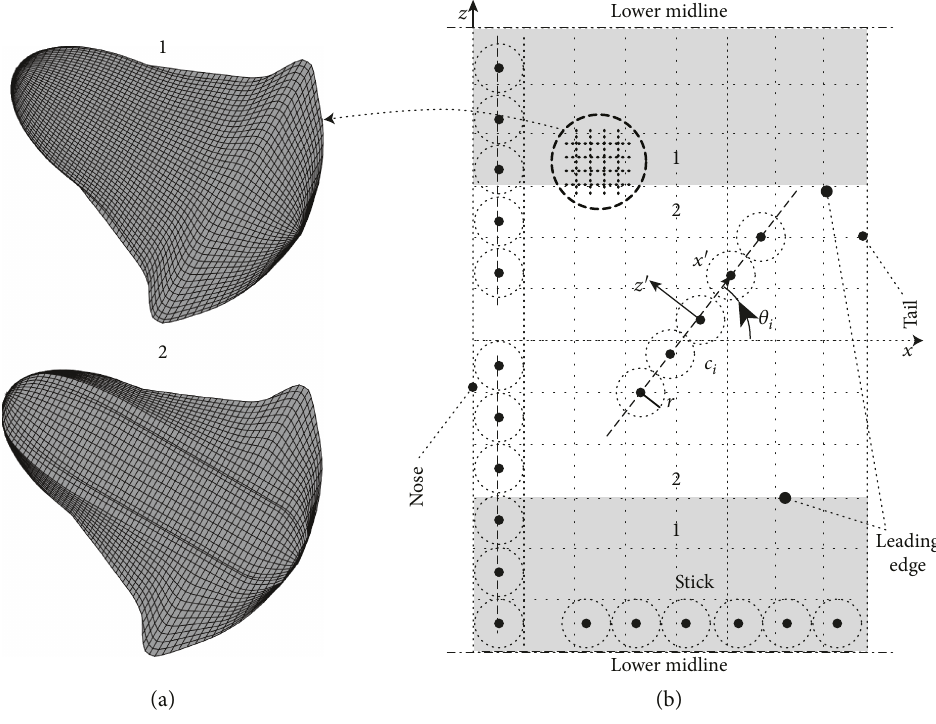
Figure 3: Morphological (a) vs. topological (b)